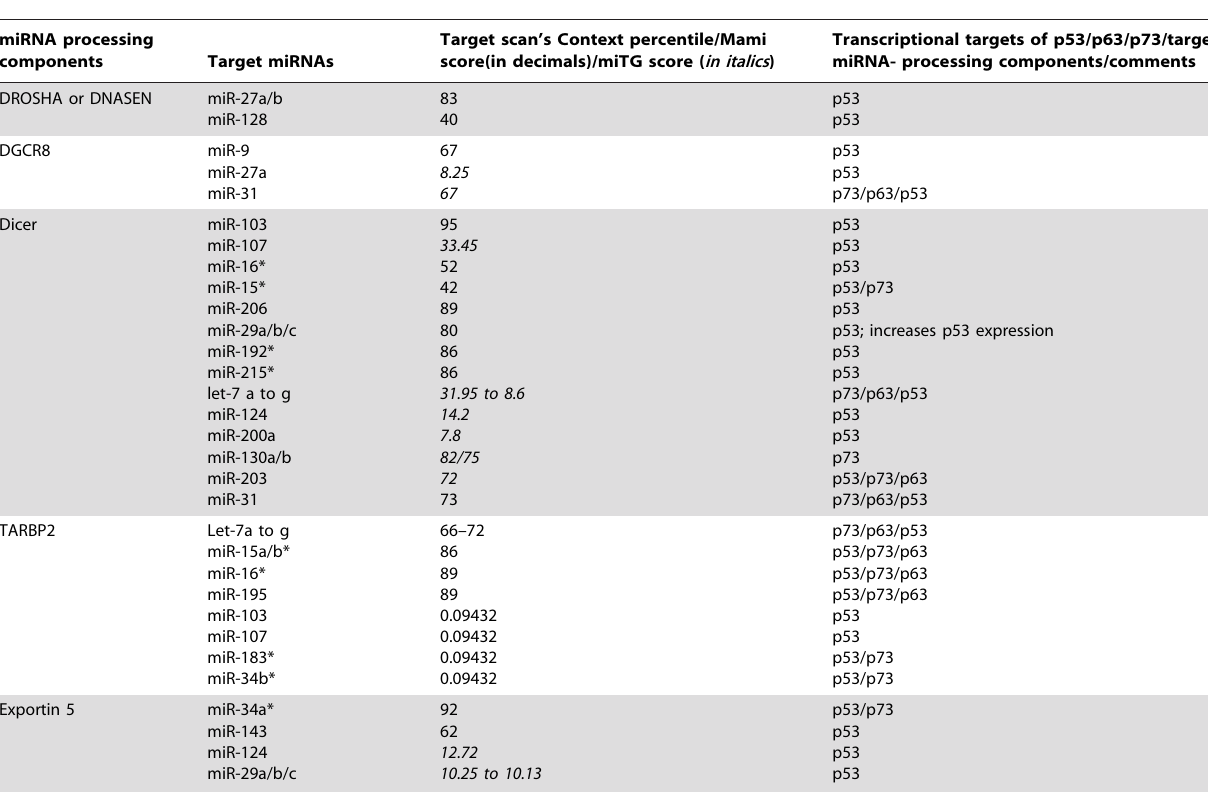
Table 2. p53/p63/p73-microRNAs that target essential components of the miRNA processing machinery.